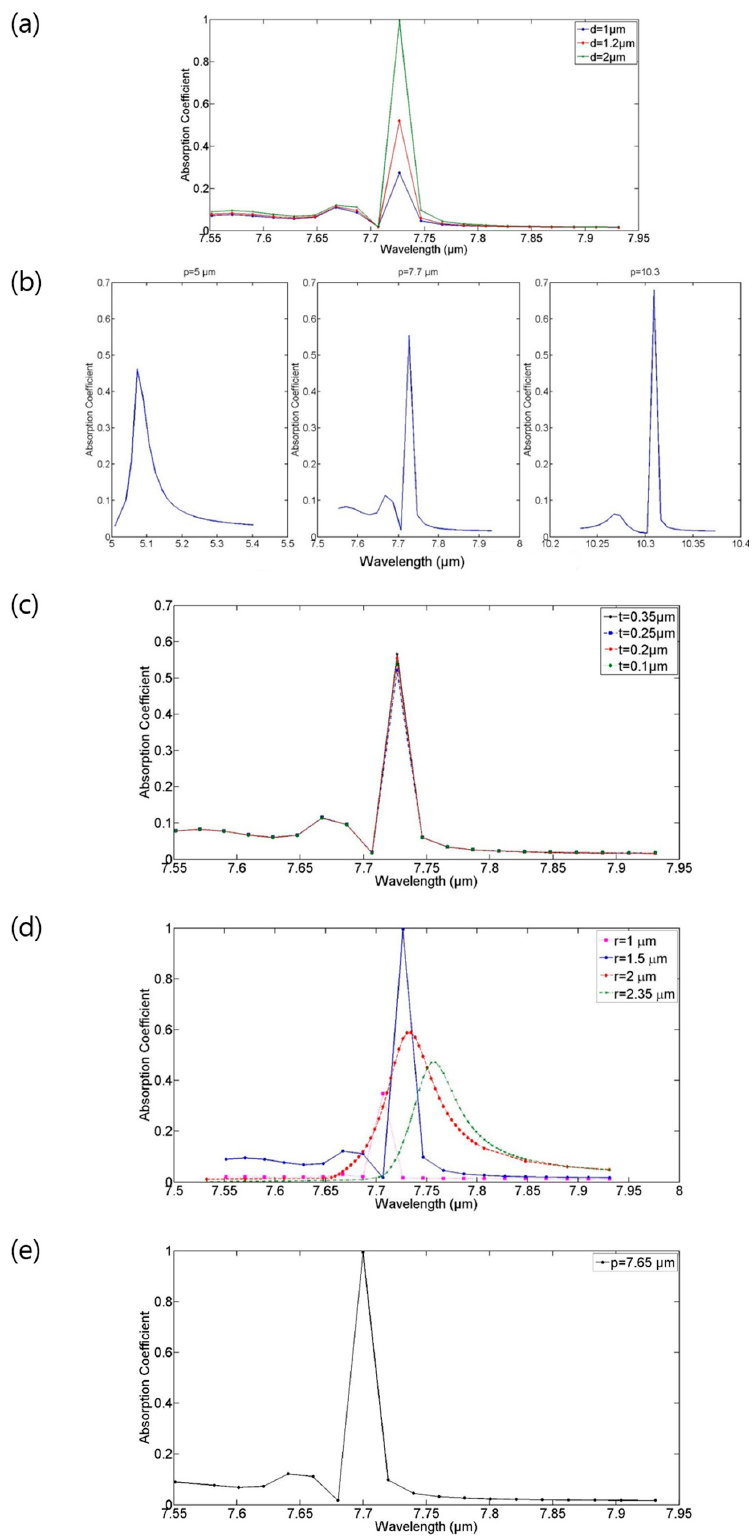
Figure A1. ( a ) The effect of the hole depth on the absorption spectrum; ( b ) The effect of the pitch on the absorption spectrum; ( c ) The effect of the gold layer thickness on the absorption spectrum; ( d ) The effect of the hole radius on the absorption spectrum; ( e ) Absorption spectrum of the final design of the plasmonic crystal structure: p = 7.65 µm, r = 1.5 µm, d = 2 µm, and t = 0.1 µm.